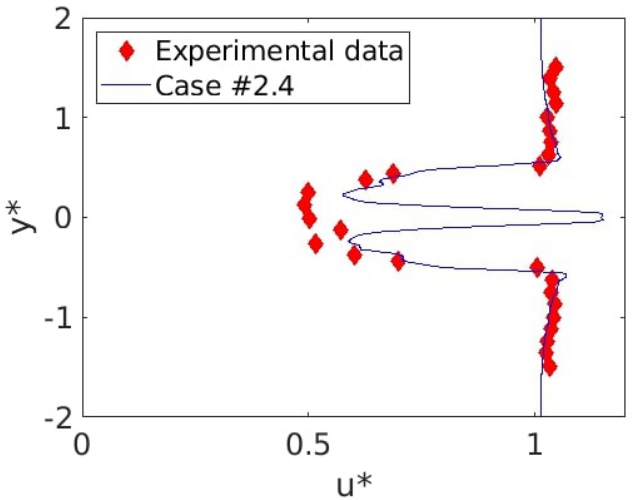
Figure 23. Non-dimensional velocity profiles according to the non-dimensional position for exper- imental data (red lozenges) and model (#2.4) as x ∗ = 1.2. The mismatch at y ∗ = 0 was due to the missing hub in the numerical case.